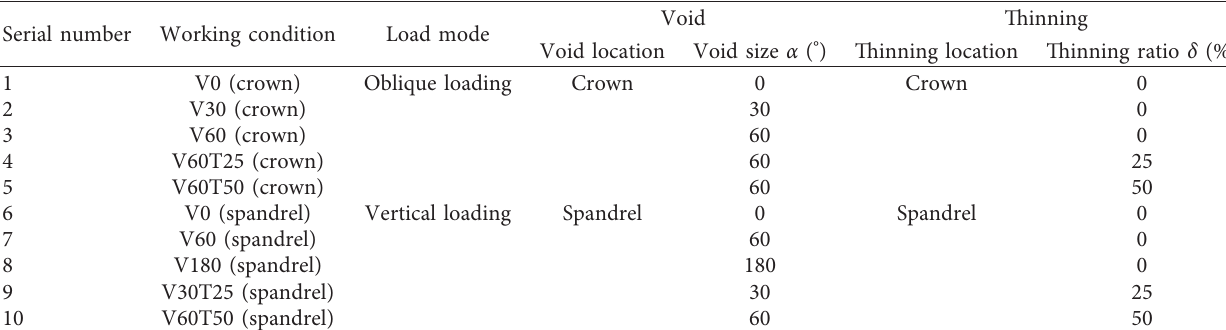
Table 2: Test conditions.